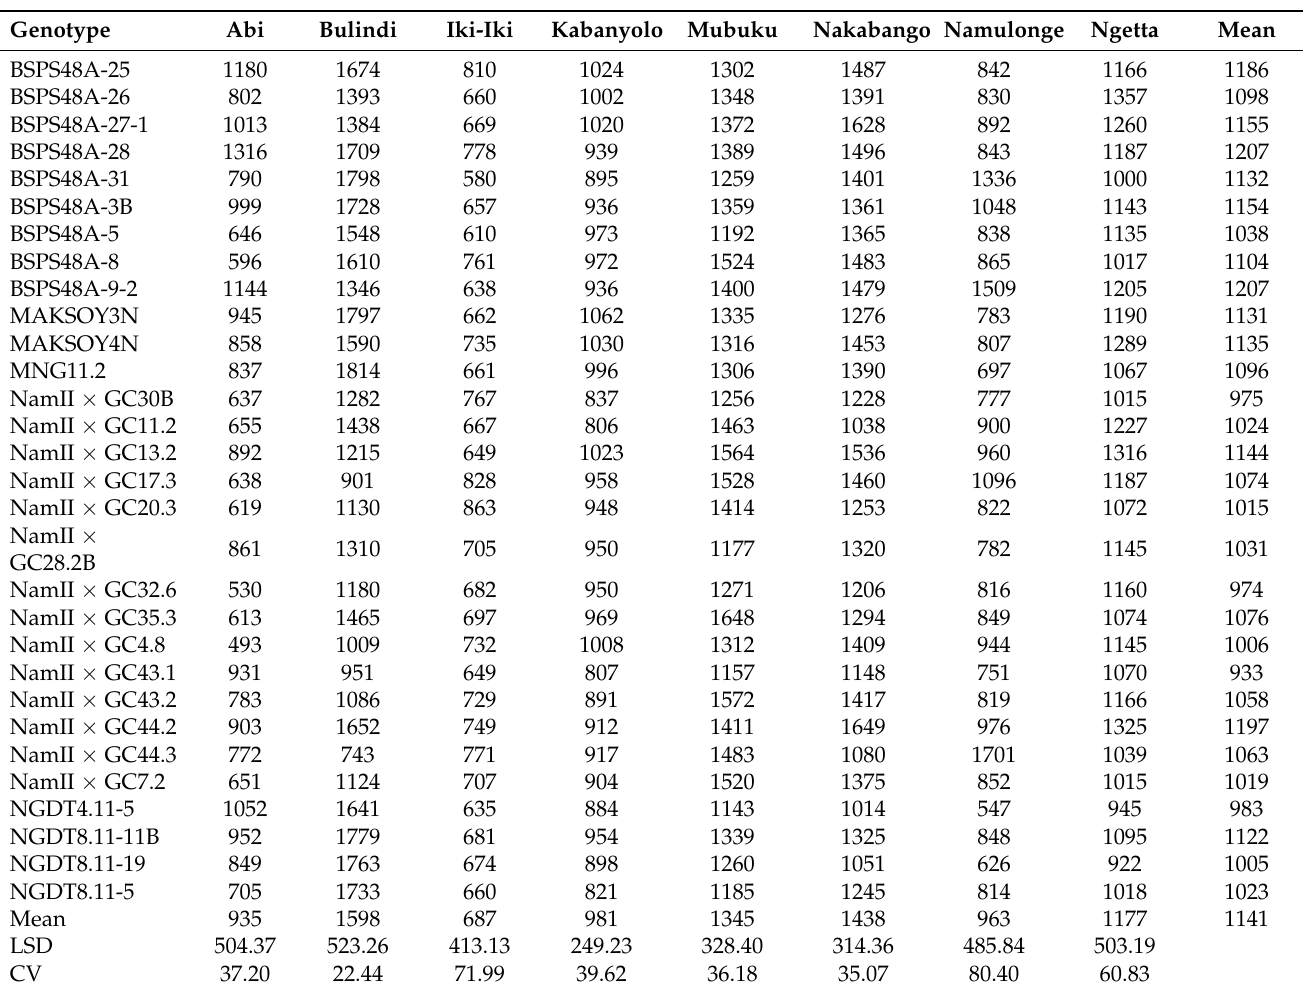
Table 6. Seed yield (kg ha − 1 ) of 30 soybean genotypes evaluated in eight locations and six seasons in